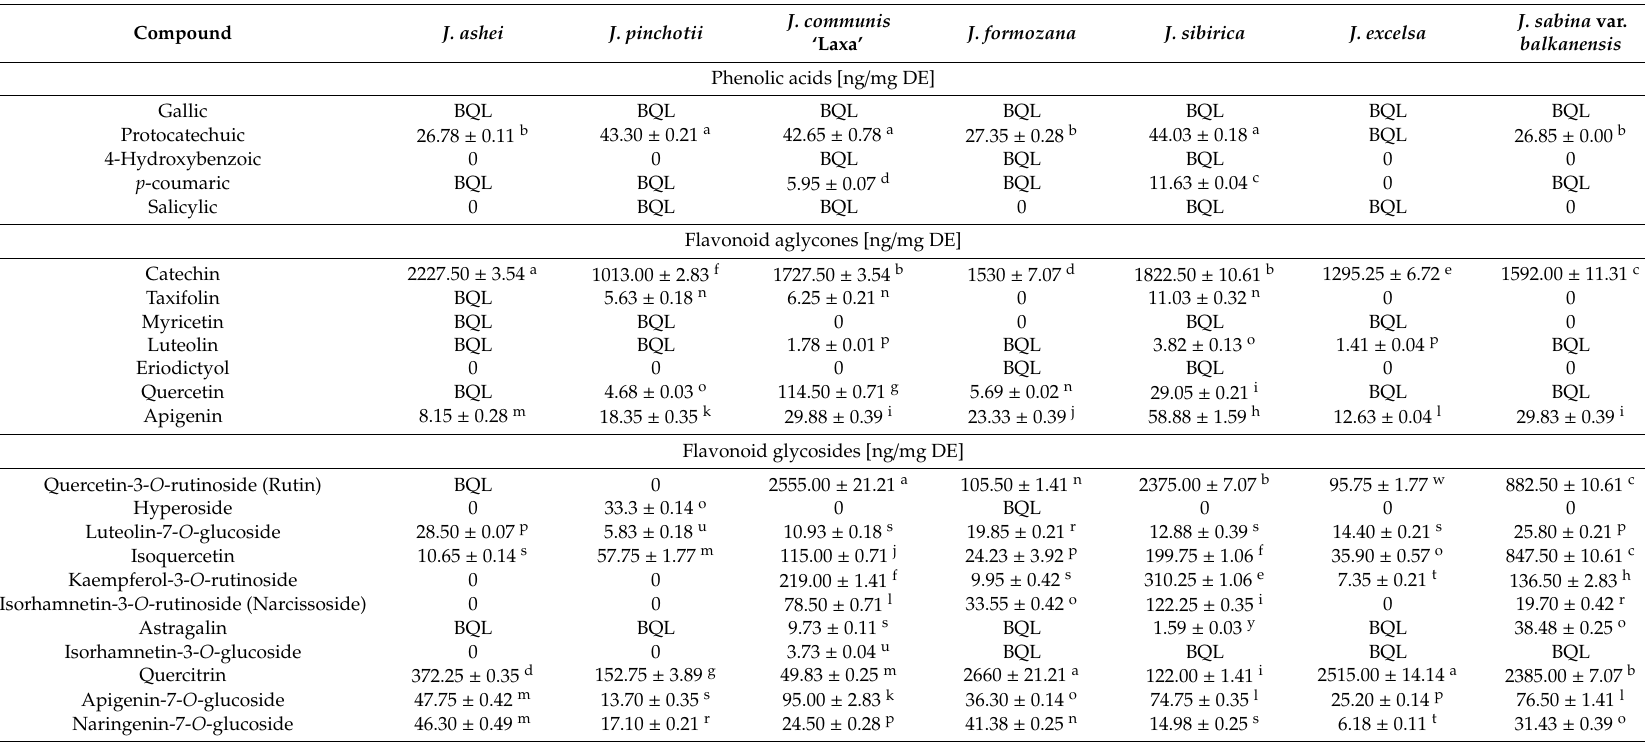
Table 2. Qualitative and quantitative LC-ESI-MS / MS analysis of polyphenols contained in extracts from leaves of selected Juniperus representatives. ESI: electrospray